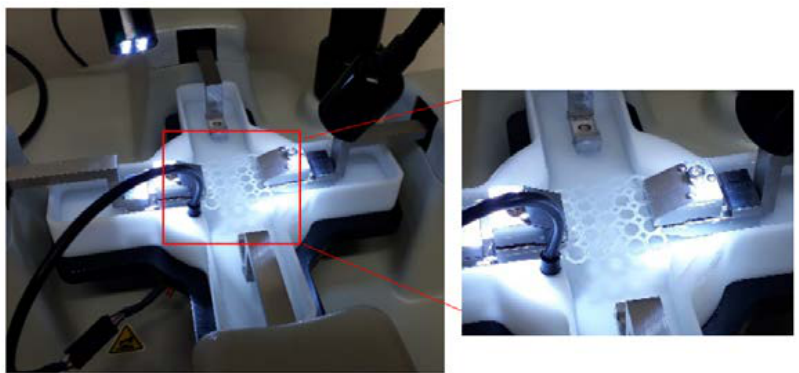
Figure 3. Equipment configuration for the uniaxial strain testing of the PCL scaffold in PBS (7.4, 37 °C).